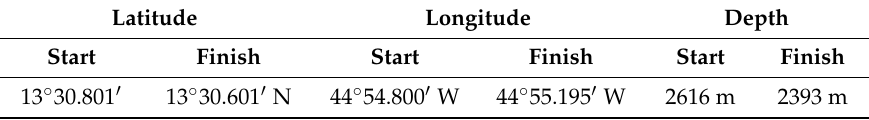
Table 1. Coordinates of the dredge station 284 at the Semenov ‐ 3 hydrothermal field.